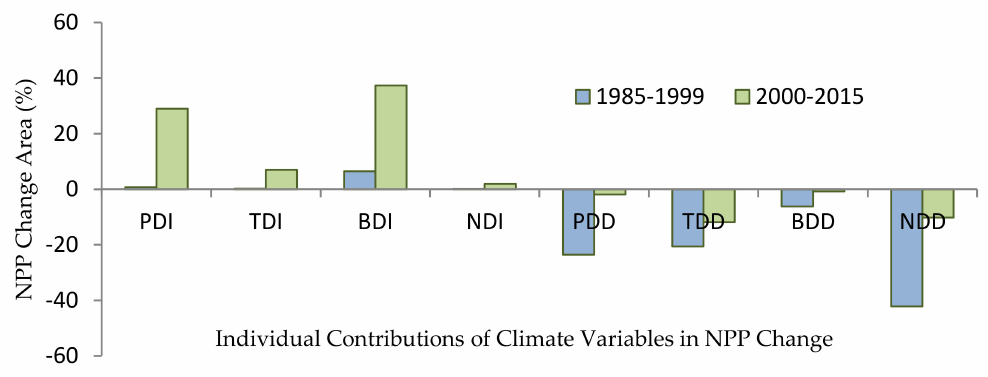
Figure 17. Individual contributions of climate variables in NPP change under di ff erent